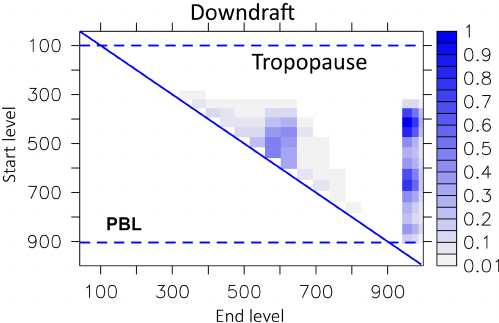
Figure 17. Similar to Fig. 16 but for parcels transported in the downdraft in 1997.